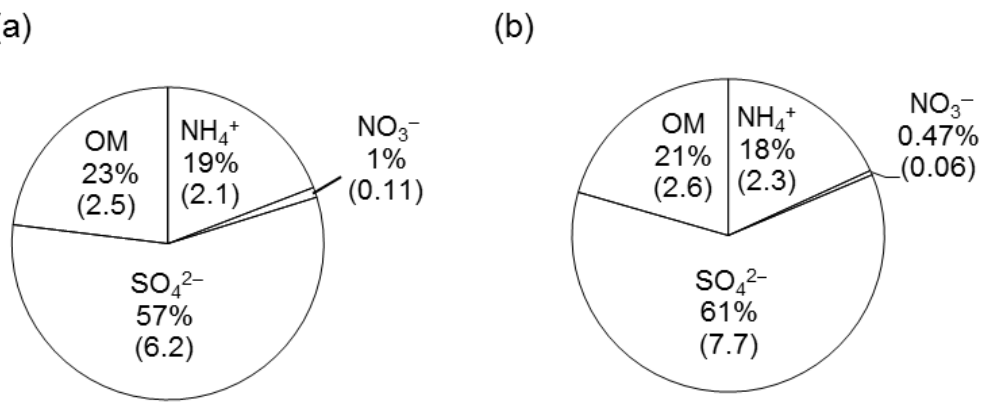
Figure 8. Relative abundances of organic matter (OM), SO 42 − , NH 4+ and NO 3 − measured by ( a ) Aerodyne aerosol mass spectrometer (AMS), and ( b ) ion chromatography and Sunset Laboratory car- bon analyzer. OM was calculated by 2.1*OC. The number in bracket means absolute amount in μ g m −3 .